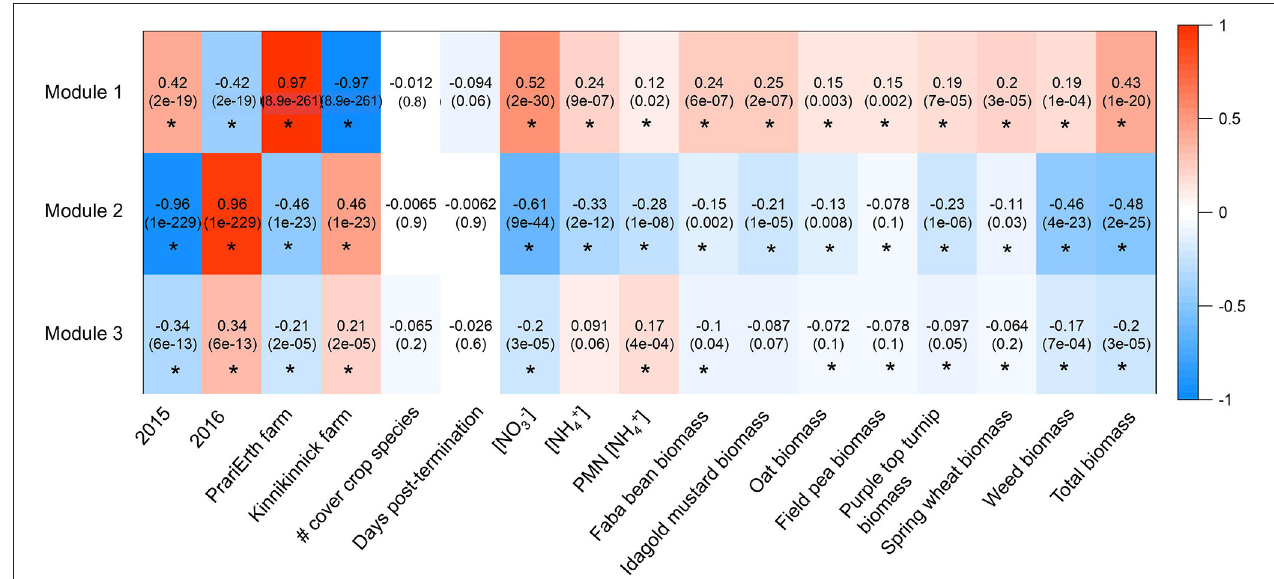
FIGURE 5 | Heatmap generated for ITS WGCNA analysis. Values are correlations and p -values are in parentheses. Asterisks indicate significant correlations at the level of p < 0.05.